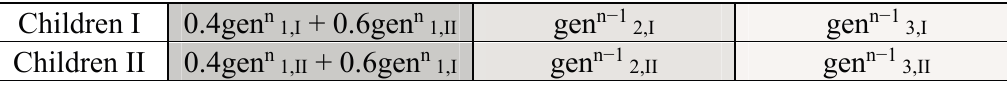
Table 4. Children chromosomes after